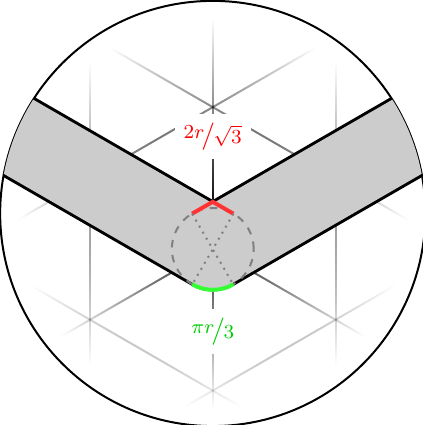
Fig. 4. An example case when ∆ x is too small in relation to r : when ∆ x = 2 r , the highlighted surface area is assigned to the Voronoi cell indicated by the dotted line, but it logically belongs to the Voronoi cells of the two vertices that lie within the hypha.